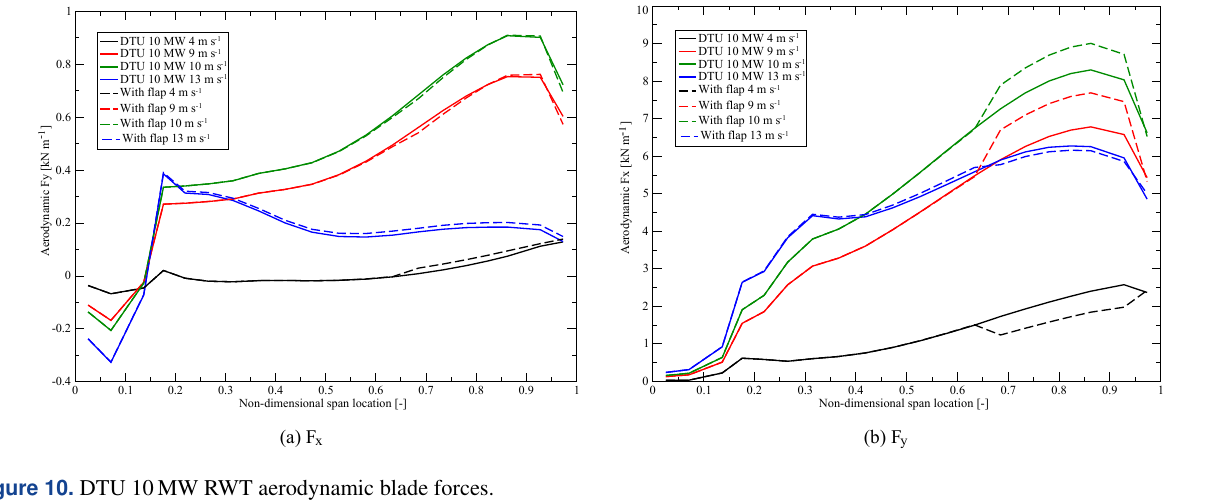
Figure 10. DTU 10MW RWT aerodynamic blade forces.